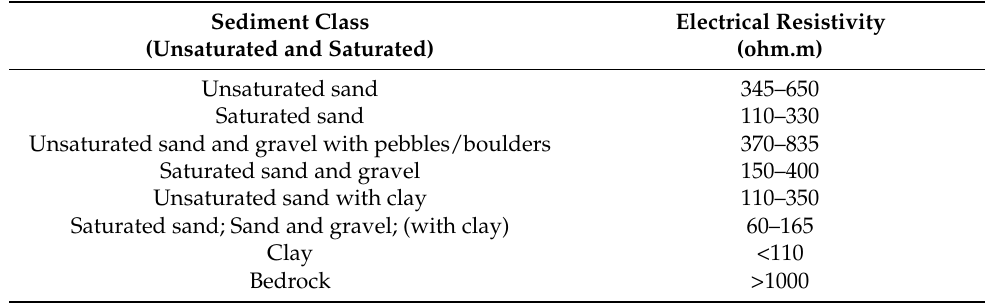
Table 1. Measured electrical resistivity of Quaternary sediments in the Saint-Narcisse moraine, eastern Mauricie, Quebec,